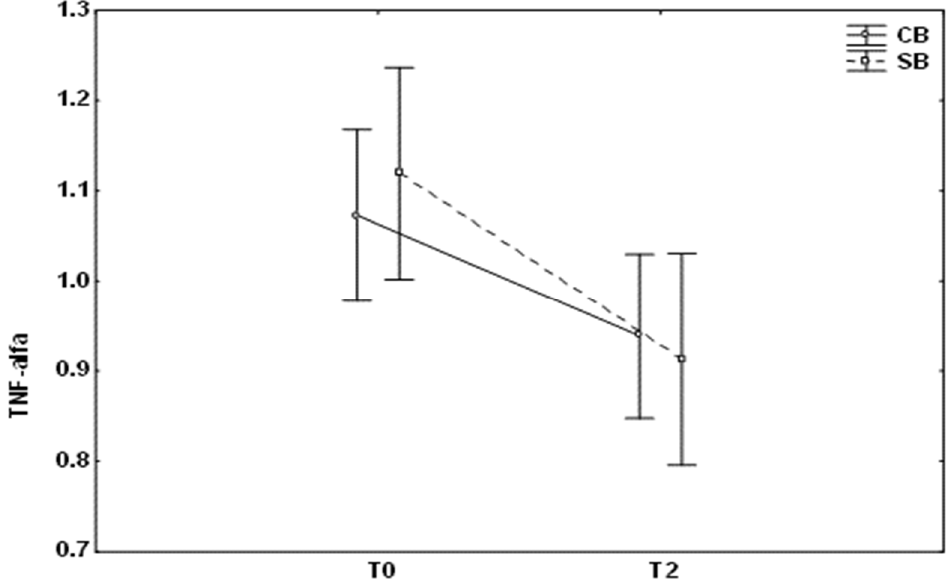
Figure 2. Changes in TNF-alpha (mean ± SD) levels at different times (T0, baseline; T2, after 2 months of the treatment) in patients with conventional brackets (CB) and self-ligating brackets (SB).